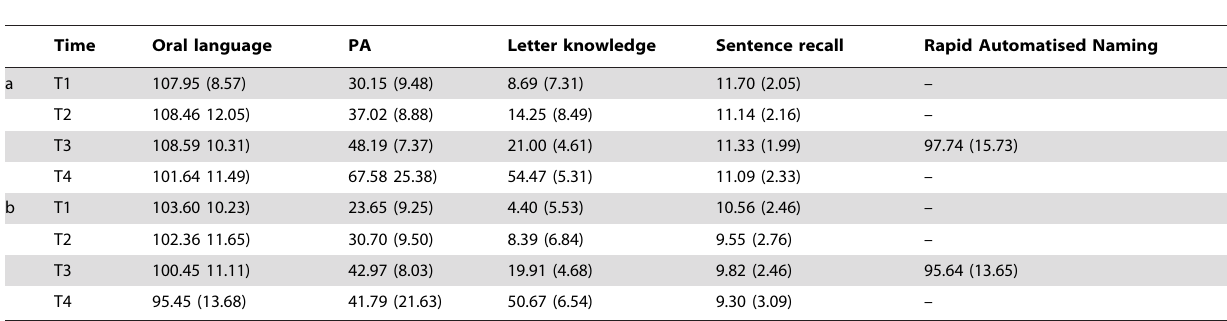
Note: Standard scores on measures of letter knowledge and PA were not available. Possible maximum score for Letter Knowledge at T1,T2 & T3=26, but at T4=60; possible maximum score for PA at T1, T2, & T3=50, but at T4=62 (see text). Scores on the Oral Language and RAN were standard scores (i.e., M =100; SD =15), and scores on the sentence recall were scaled scores (i.e., M =10; SD =3).